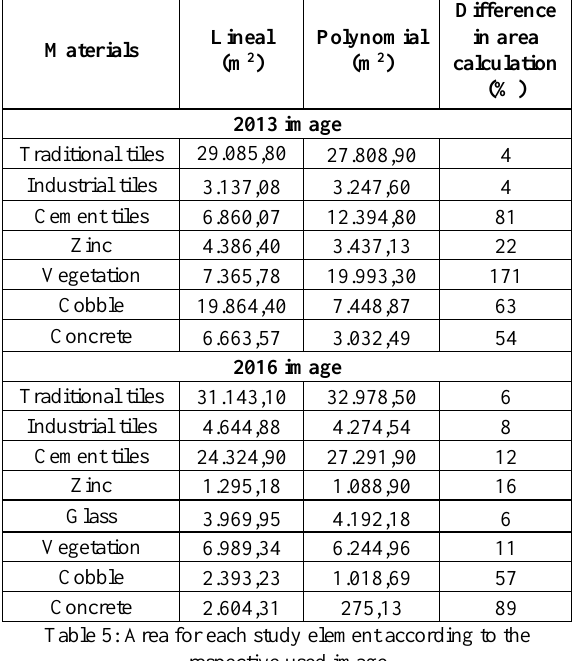
Table 5: Area for each study element according to the respective used image Source: Authors, 2016